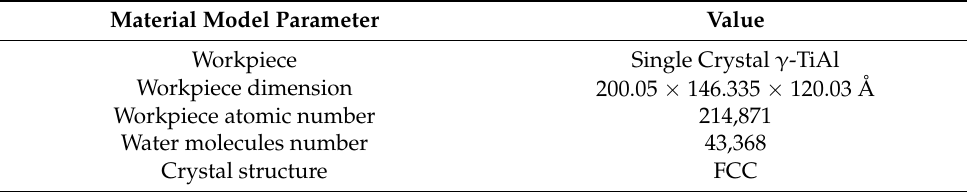
Table 2. Material model